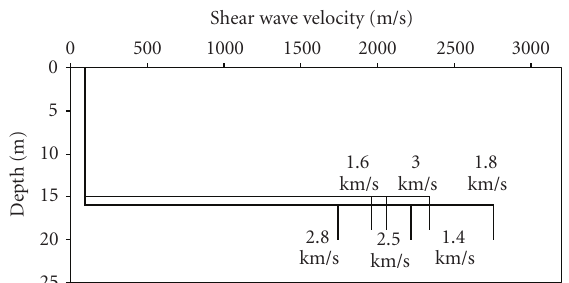
Figure 6: Layer models of depth-shear wave velocity for NRC site. Shear wave velocity profiles for di ff erent bedrock velocities (in km/sec) of the initial model, shown at the end of each profile. Contrast ratio and bedrock depth velocity are